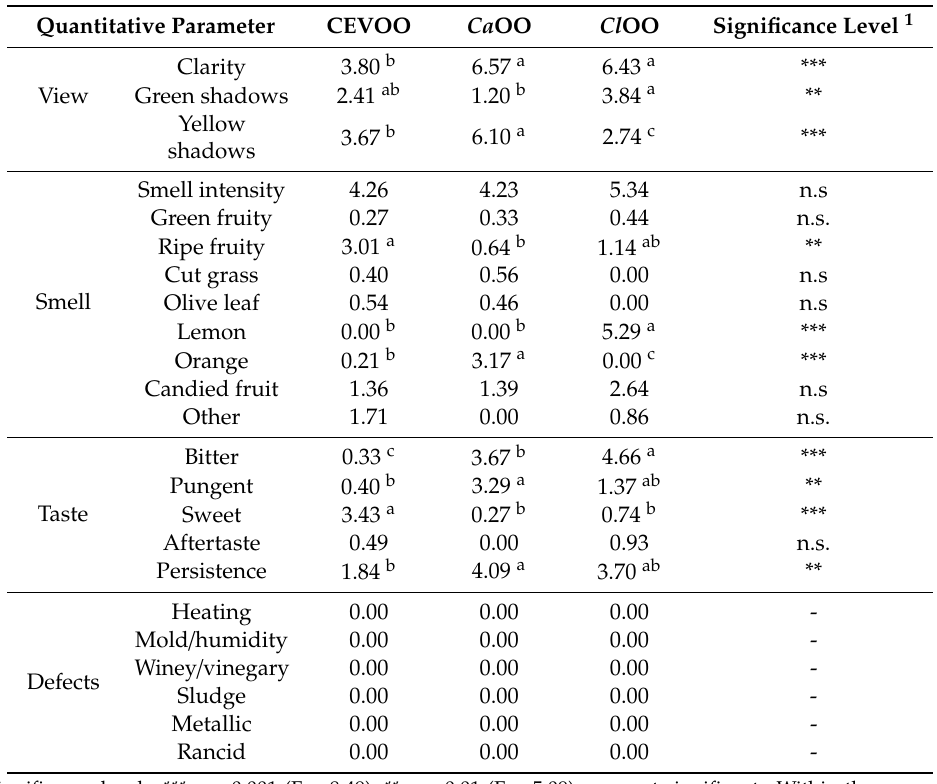
Table 7. Two-way ANOVA calculated for all the parameters evaluated by panelists during tasting sessions for the three olive oils, with the panelists and addition of citrus peels as main e ff ects. Quantitative Parameter CEVOO Ca OO Cl OO